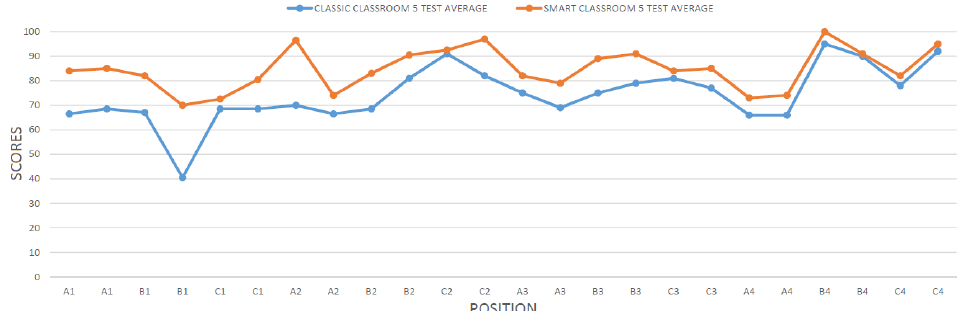
Figure 15. Average score chart of the five tests applied in classical and smart classrooms.